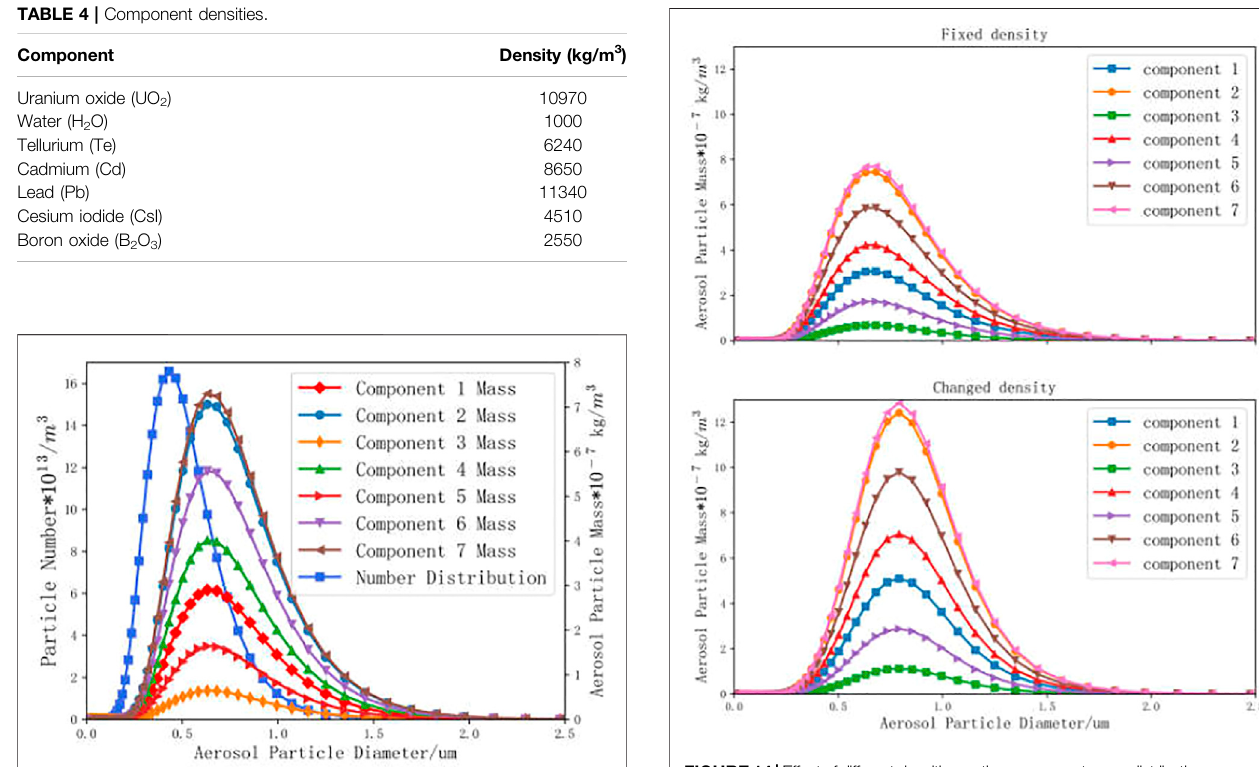
FIGURE 12 | Initial aerosol distribution.